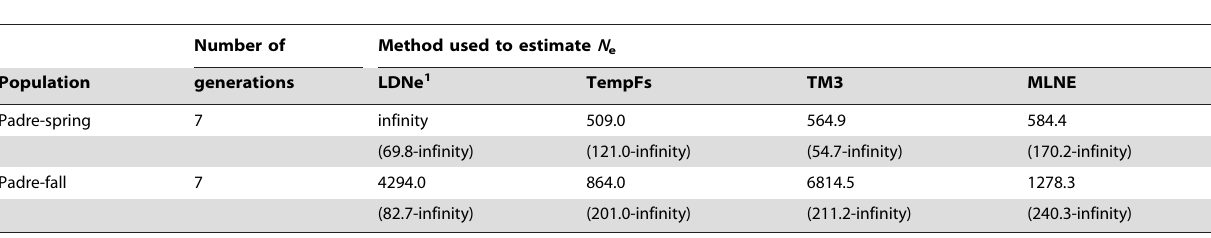
Table 2. Estimates of N e for the migrant peregrine falcon population at Padre Island, TX.